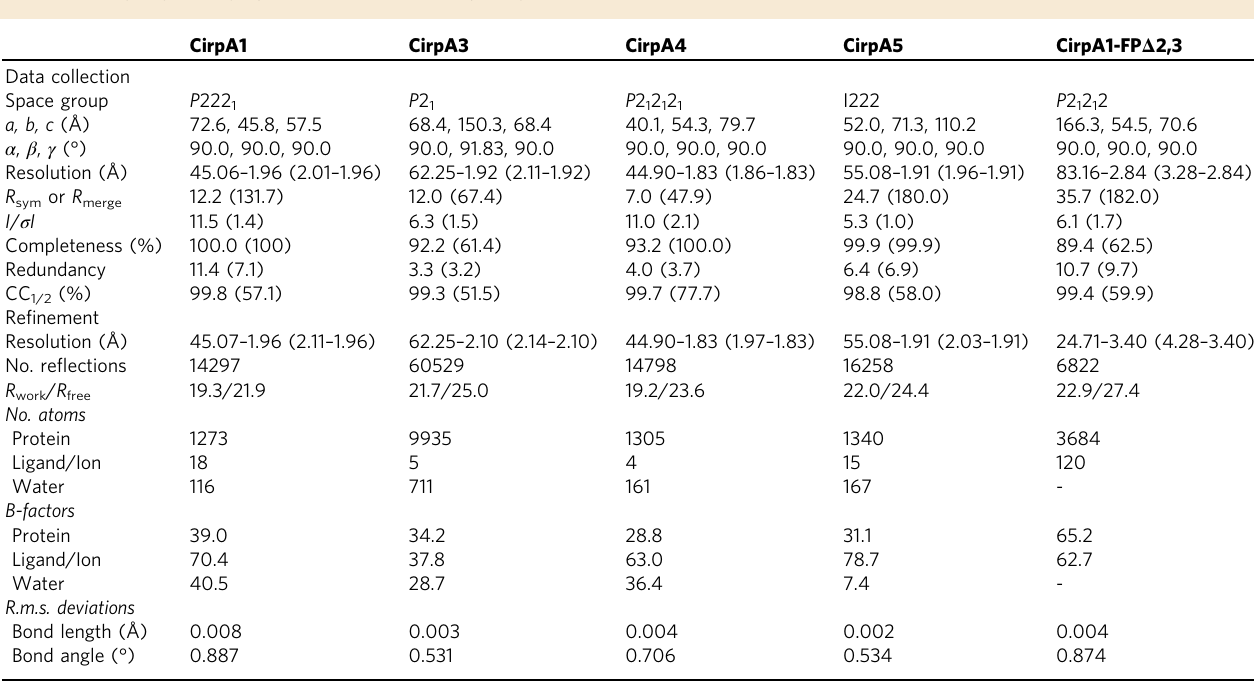
Table 1 X-ray crystallographic data and model quality.